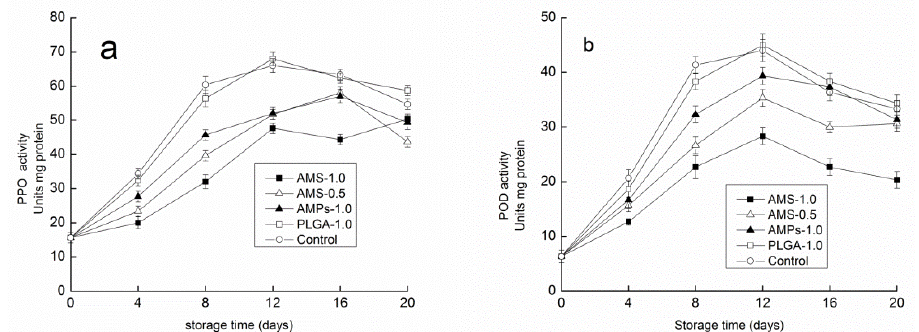
Figure 7. Effect of different antimicrobial coatings on PPO activity ( a ) and POD activity ( b ) changes of Tricholoma matsutake stored at 4 ± 1 °C for 20 days. Each data point is the mean of three replicate samples.